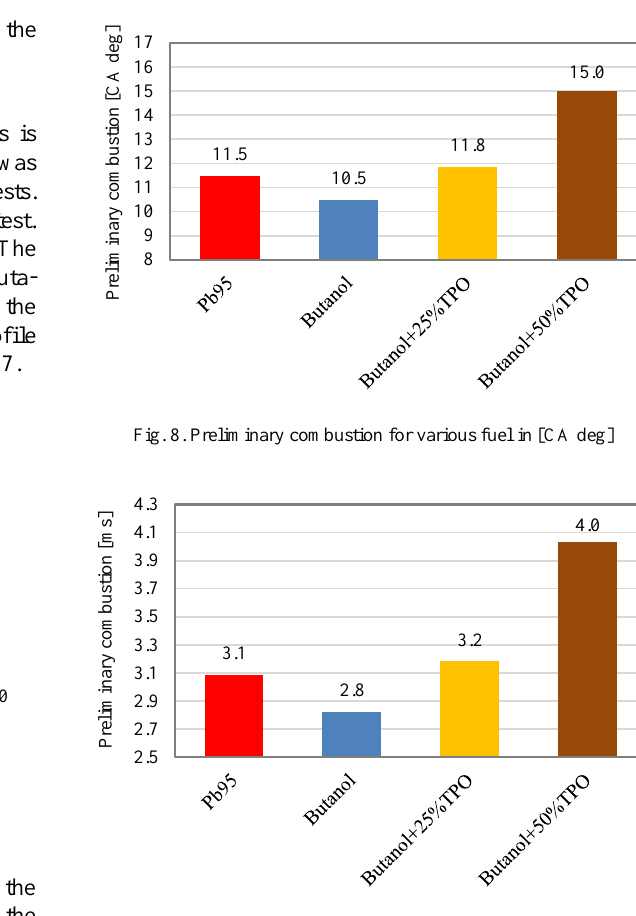
Fig. 9. Preliminary combustion for various fuel in [ms] The combustion duration phase was the shortest and al- most identical for butanol and Butanol + 25%TPO. It amounts to 13.2 CA deg, which in milliseconds gives the result of 3.55 ms. Gasoline had a longer combustion dura- tion phase by 0.7 CA deg, which in terms of time units gives the result of 3.73 ms. The combustion duration of the mixture Butanol + 50%TPO was the longest. This process lasted 15.1 CA deg what corresponds to the time of 4.06 ms (Fig. 10 and 11).